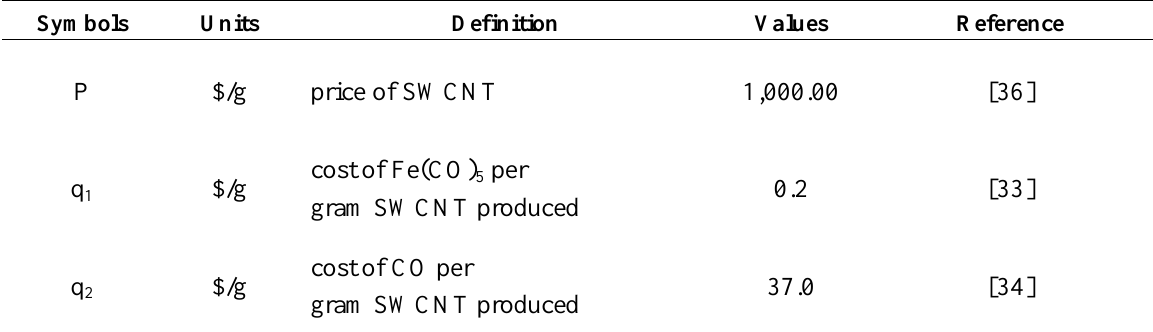
Table 4. Summary of Parameters for NLP and CCNLP